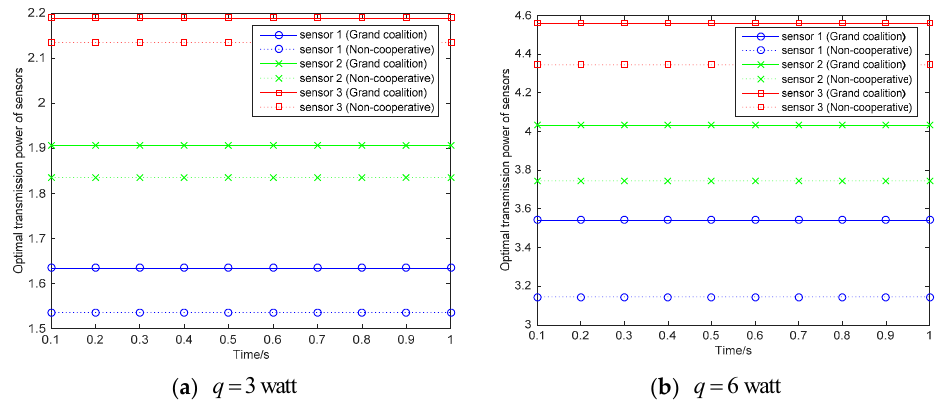
Figure 3. Optimal power level for information transmission of each sensor.